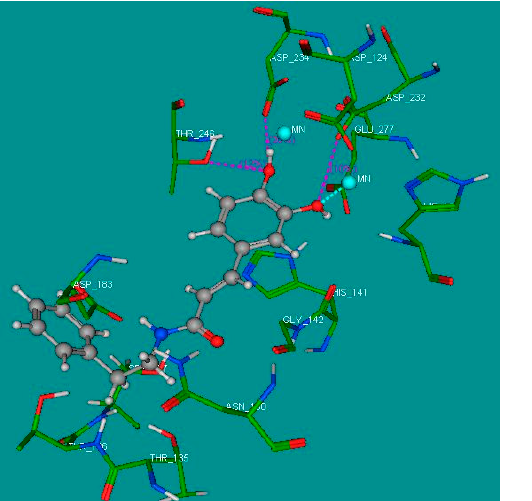
7 of 16 Figure 4. 3D ( left ); and 2D ( right ) binding modes of CGA inside the active site of h-ARG I. For the 3D binding mode, CGA is represented as a “ball and stick” form: C ( grey ), O ( red ), and H ( white ); manganese ions are represented as cyan spheres; and the crucial residues of the binding site are represented by lines. H-bonds are represented as pink dotted lines, while the metal coordination bonds are represented by cyan dotted lines. Docking simulations were performed by FlexX program implemented in LeadIt 2.0.2 software, and the pictures of docking solution were created by MOE 2008.10 software. Since CAPA was identified as a potential lead compound of the series, interactions of this